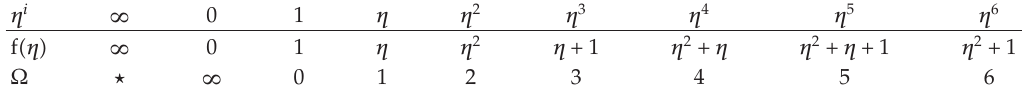
(cid:3) 8 (cid:4) 1